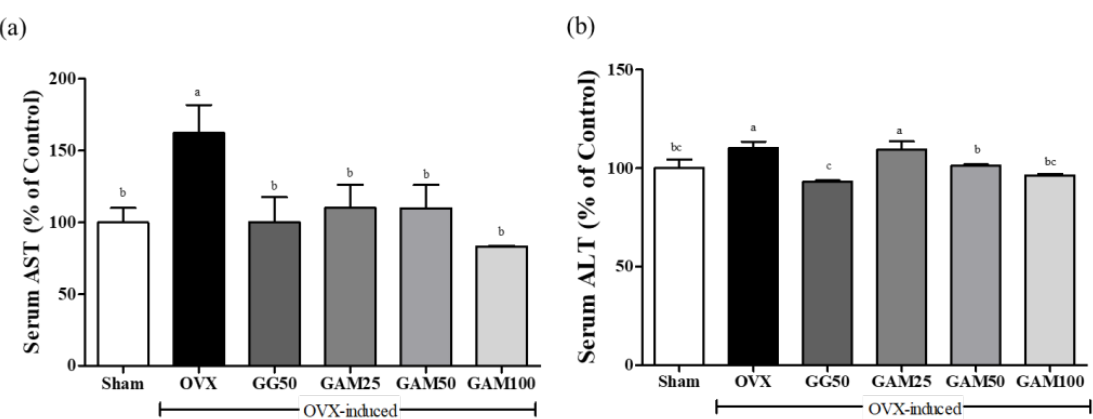
Figure 2. Effects of GAM on liver functions in OVX-induced rat models. The effects of GAM on ( a ) AST and ( b ) ALT were evaluated using ELISA assay kits. a–c Mean values with different letters differed significantly ( p < 0.05) among groups, as shown by Tukey’s test.